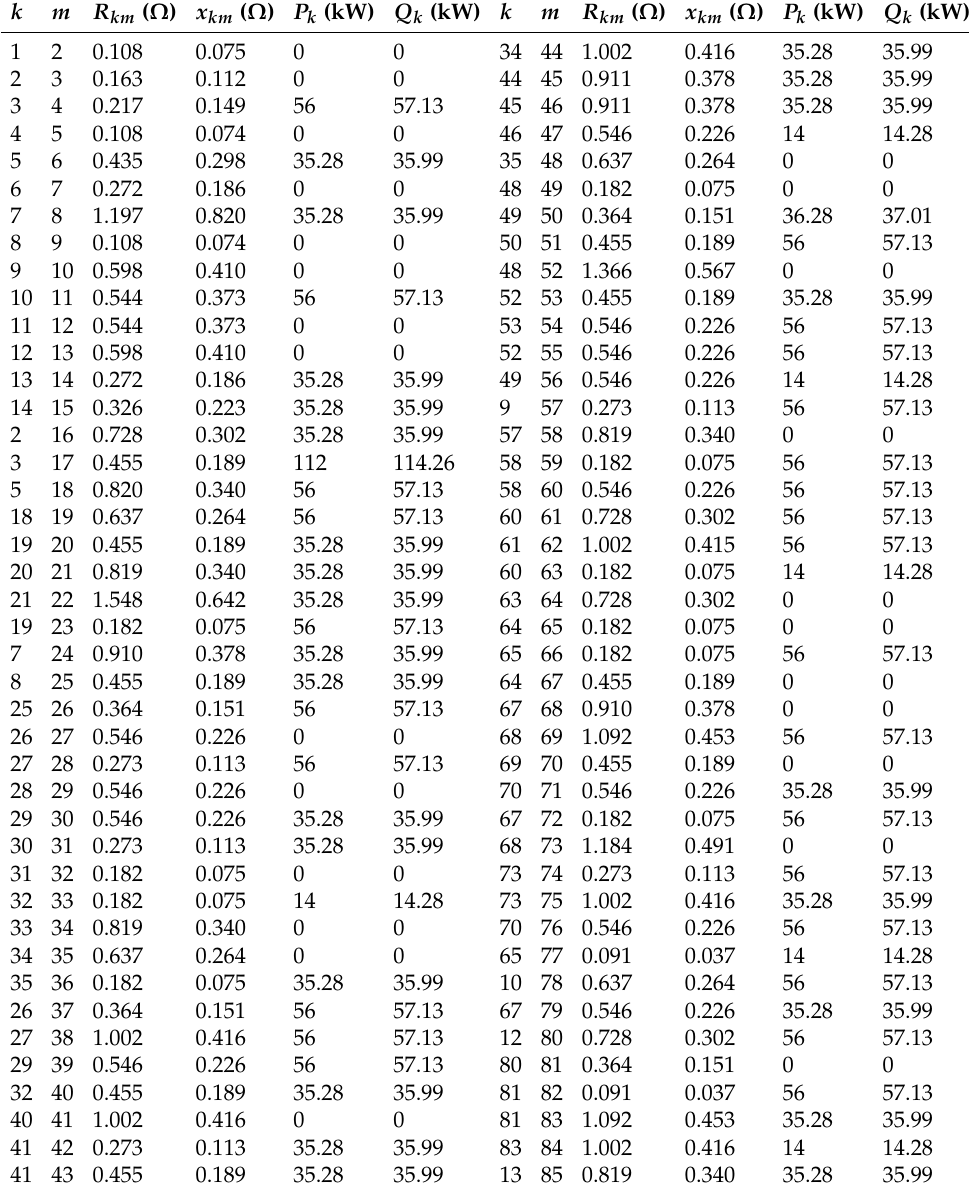
Table 9. Parametric information regarding branches and loads in the IEEE 85-bus